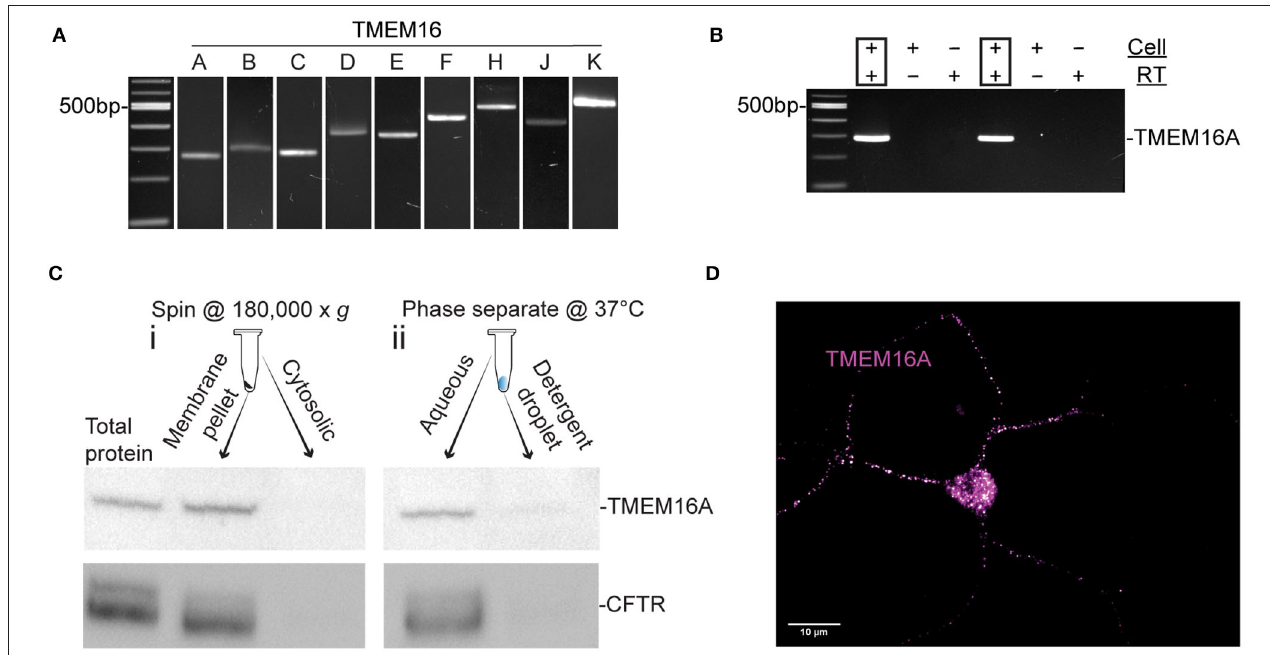
FIGURE 1 | TMEM16A transcript and protein are expressed in retinal amacrine cells. (A) RT-PCR of RNA extracted from E16 retinal tissue for TMEM16 paralogues. (B) Single-cell PCR amplifying TMEM16A from individual AC. Each cell was DNase-treated prior to reverse transcription. RT (–) and template (–) controls showed no amplification. (C) Western blot of subcellular fractionated protein samples (i) and Triton x-114 cloud point extraction samples (ii) show immunodetection of TMEM16A (Abcam ab190803) and CFTR (Abcam ab131553) in the same fraction with both types of membrane preparation. (D) Immunocytochemistry for TMEM16A reveals a punctate labeling along with the soma. The image is displayed with a magenta-hot look-up table that shows puncta with high-fluorescence intensity as